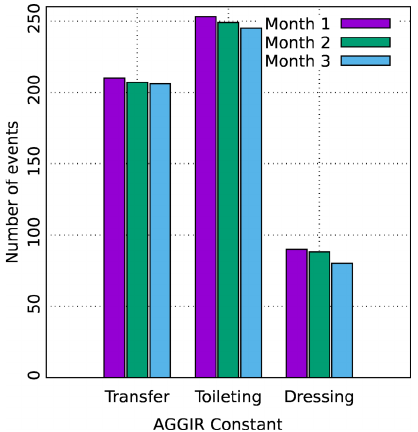
Figure 18. Three-month algorithm scalability.